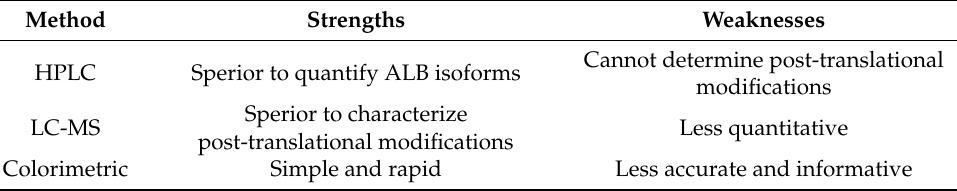
Table 1. Analytic methods for serum albumin (ALB) redox